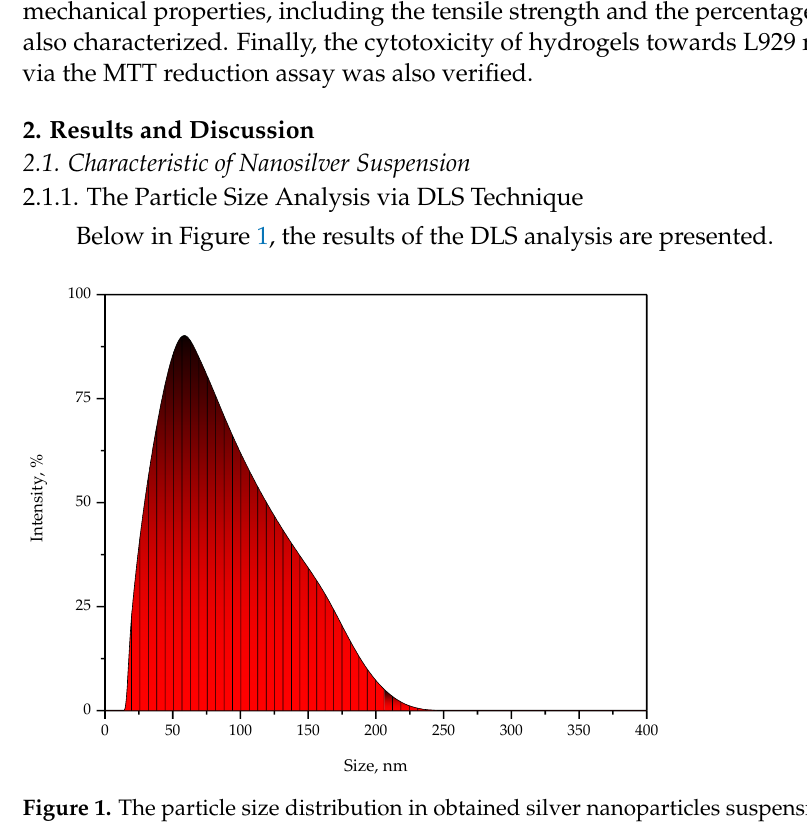
Figure 1. The particle size distribution in obtained silver nanoparticles suspension.